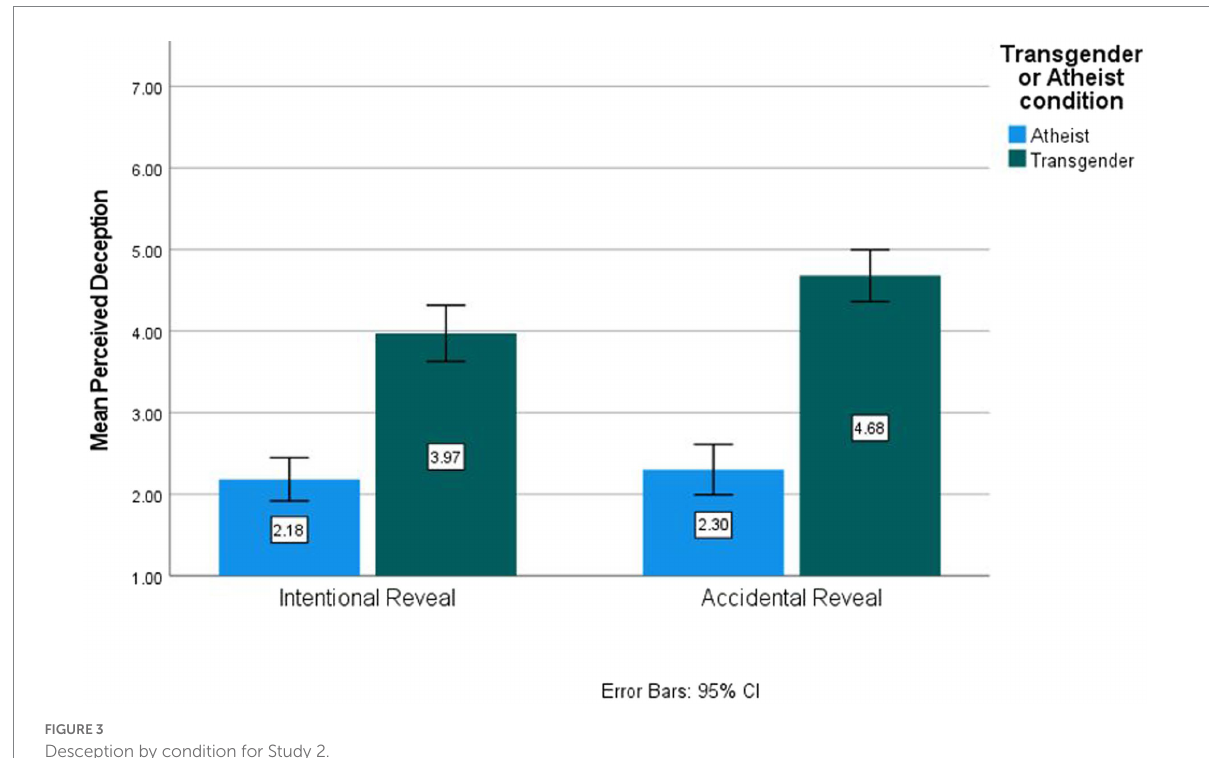
FIGURE 3 Desception by condition for Study